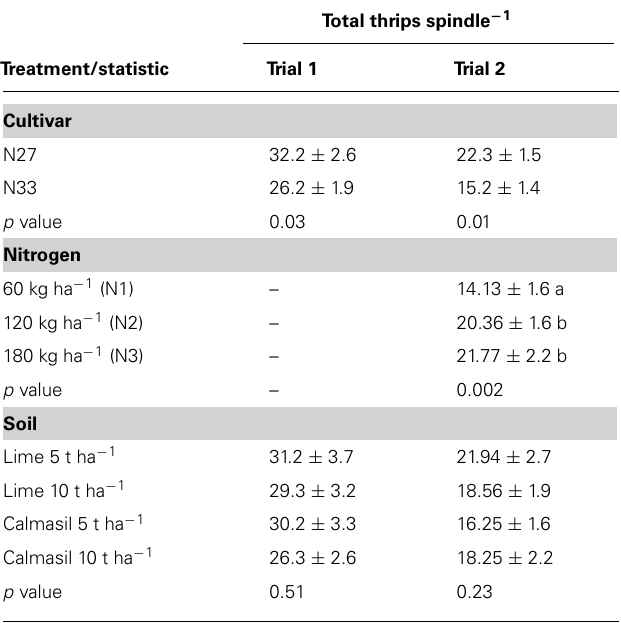
Table 3 |Thrips abundance inTrials 1 and 2 at 3 months in response to cultivar, soil, and nitrogen treatments.